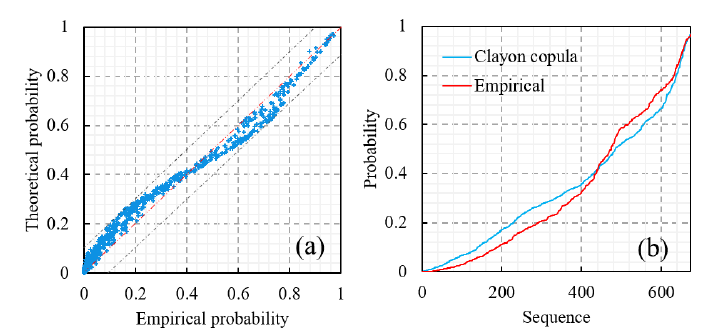
Figure 14. Comparison of theoretical and empirical probability with Clayon copula: ( a ) Q-Q plots; ( b ) empirical and theoretical